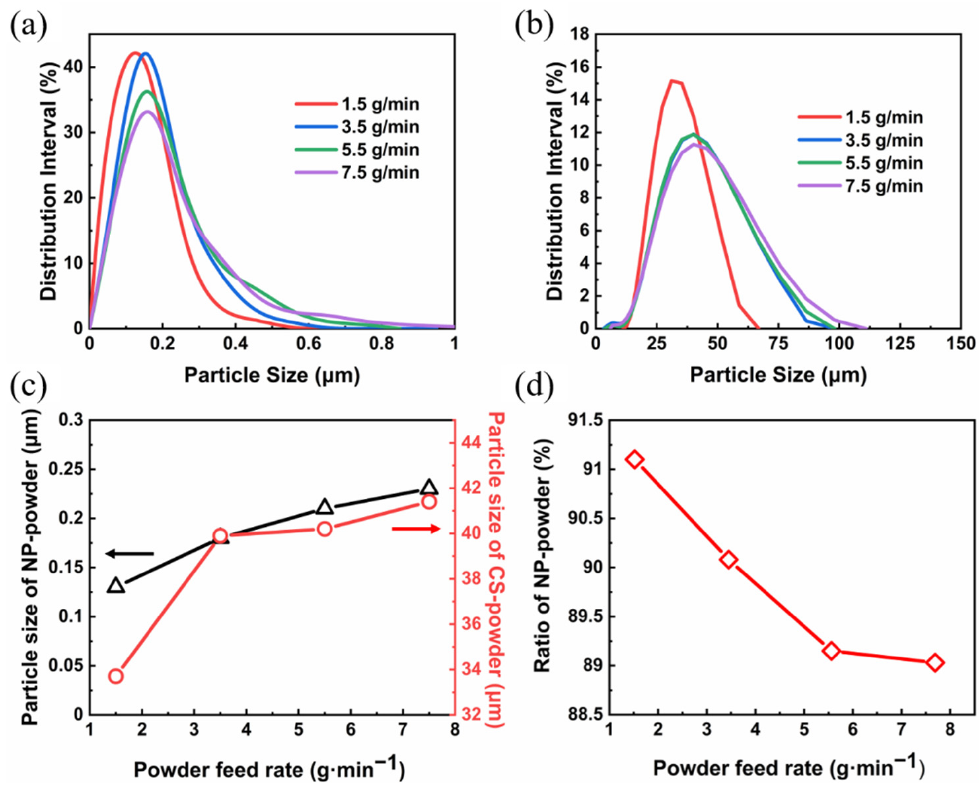
Figure 3. Particle size distribution of the ( a ) NP-powder and ( b ) CS-powder; ( c )average particle size (D 50 ) of the NP-powder and CS-powder, ( d ) ratio of the NP-powder at different powder feed rates.